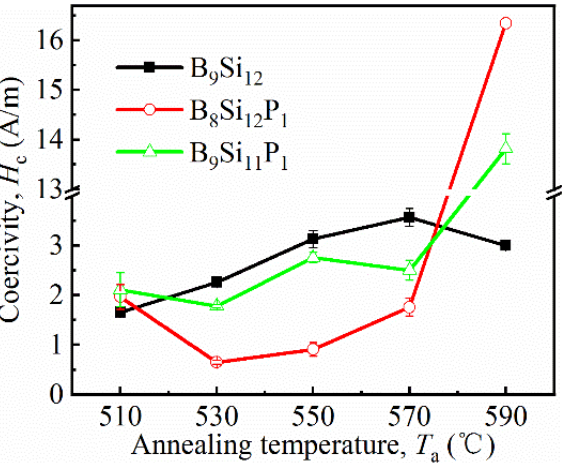
Figure 3. H c of B 9 Si 12 , B 8 Si 12 P 1 and B 9 Si 11 P 1 ribbons as a function of annealing temperature. The annealing time is 60 min.